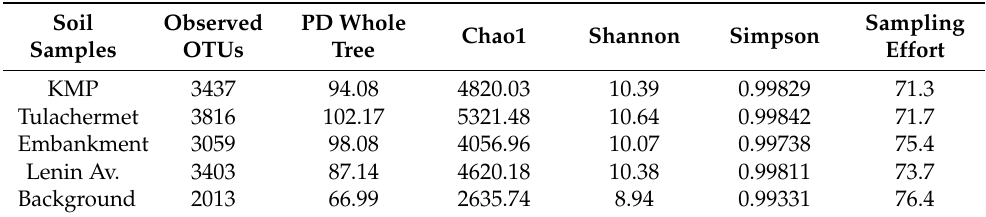
Figure 1. The number of cultivable heterotrophic bacteria, actinomycetes, and micromycetes in the rhizosphere of E. frumentacea . ( a )—bacteria; ( b )—actinomycetes; ( c )—micromycetes. Error bars mean standard errors/*— p < 0.05 for the difference between experimental and background